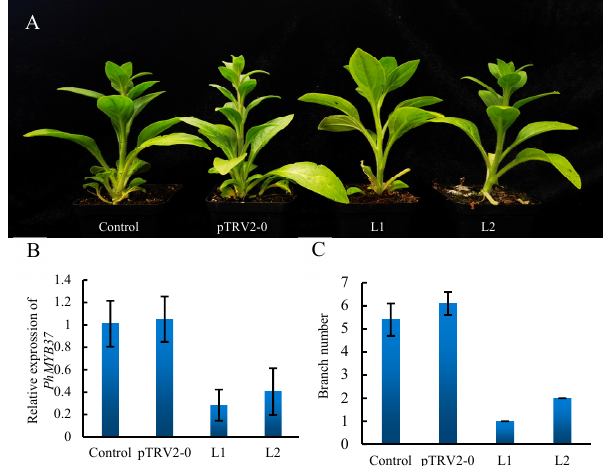
Figure 7. Analysis of the branch number phenotype and PhMYB37 silencing in petunia. ( A ) Comparison of the phenotypes of control and pTRV2-0 or pTRV2-PhMYB37-infected plants. Different lines that were infected with pTRV2-PhMYB37 are represented by L1 and L2. ( B ) qRT-PCR was used to detect PhMYB37 transcripts in the total RNA of leaves. The SD of three biological replicates is displayed in error bars. Three pools of 20 plantlets each included four samples: control, pTRV2-0, Line 1 (L1), and L2. ( C ) The branch numbers of the control, pTRV2-0, L1, and L2 plants are displayed ( n = 15).